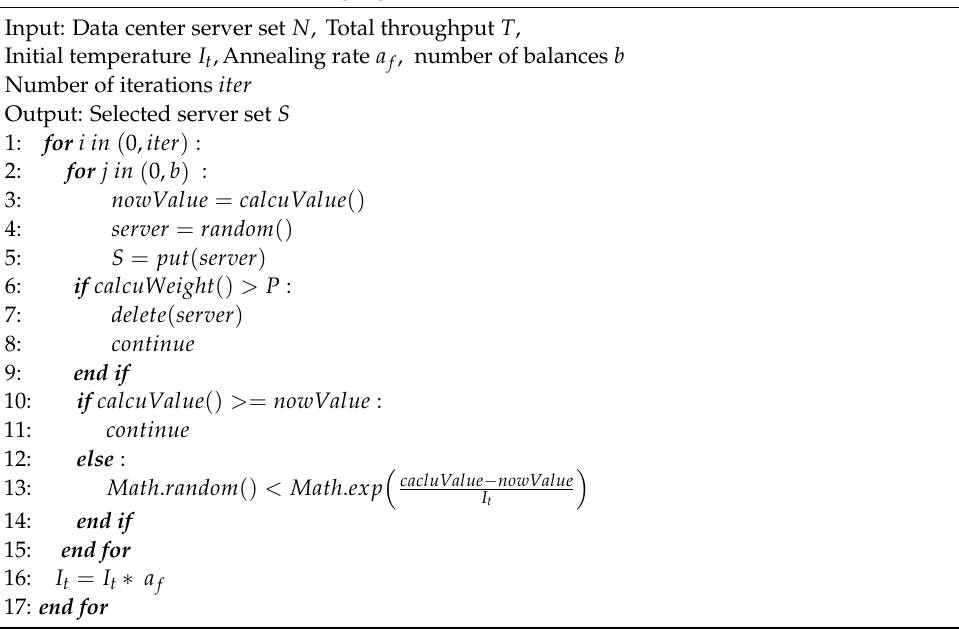
Algorithm 4: Simulated Annealing algorithm